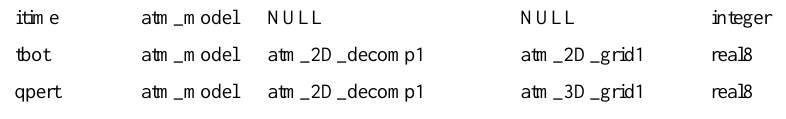
facilitates the second approach. At each time of “config- ure” of a model simulation, a package of the correspond- ing experimental setup is automatically generated and